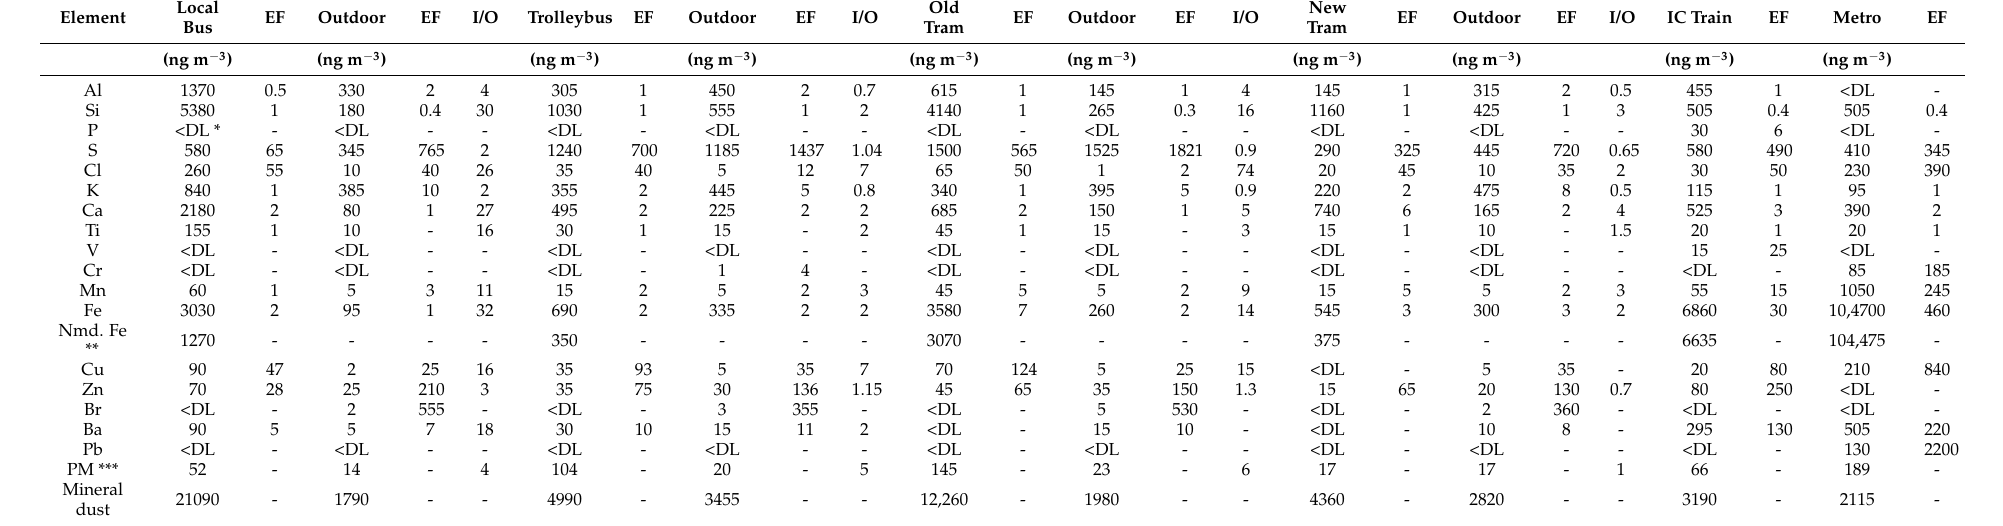
Table 6. Elemental concentration, mineral dust concentration and Enrichment Factor (EF) in PM 2.5 fraction in different vehicles in 2014; outdoor concentration (ATOMKI monitoring site) with EF and indoor/outdoor (I/O)